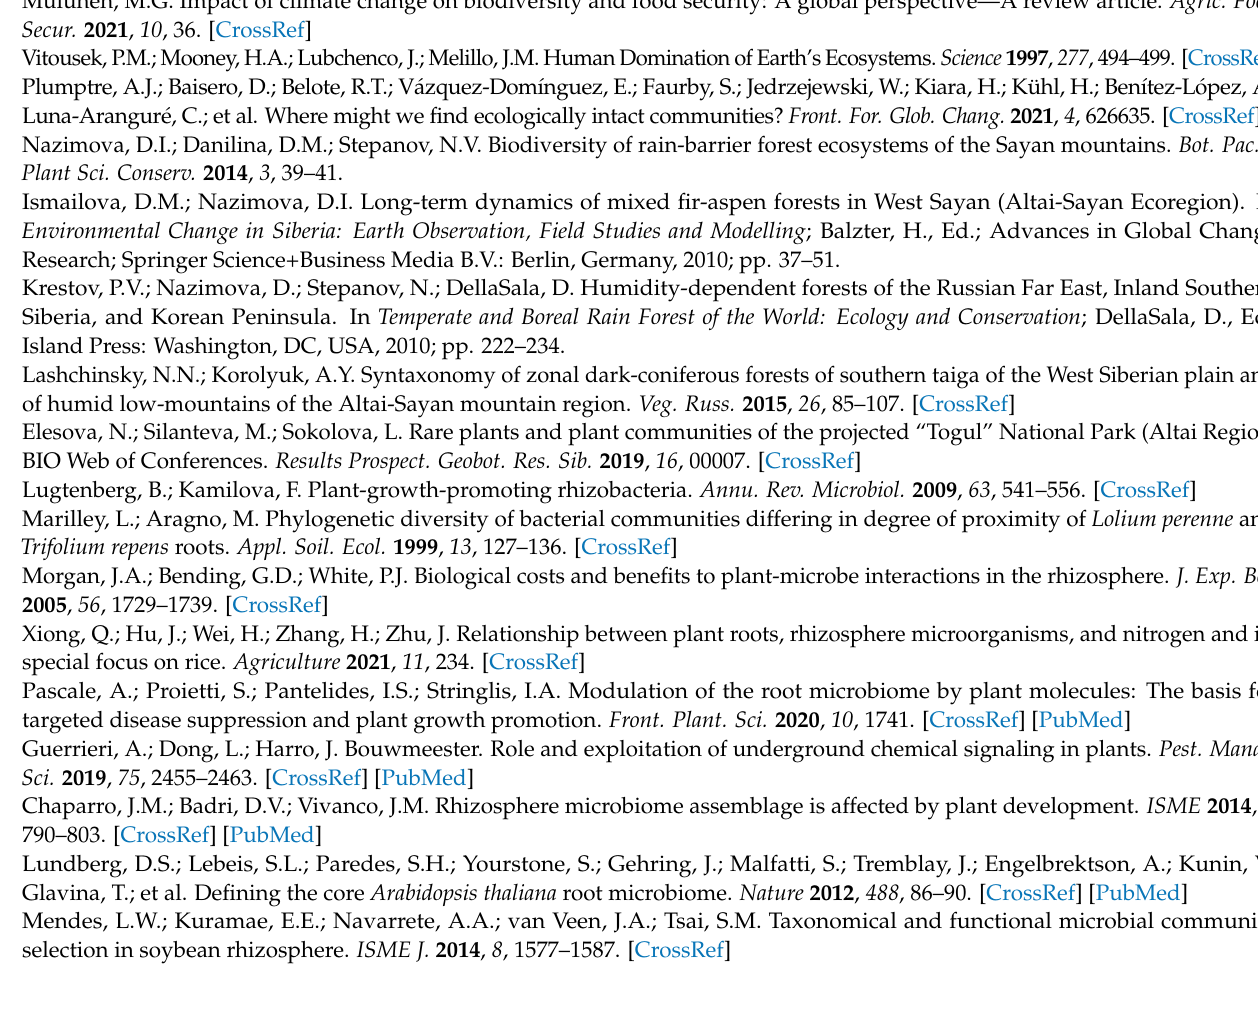
Table S2: Effect size analysis (LDA) for the prokaryotic taxa in the rhizosphere of plants growing on the Chernevaya soil relative to those on the control